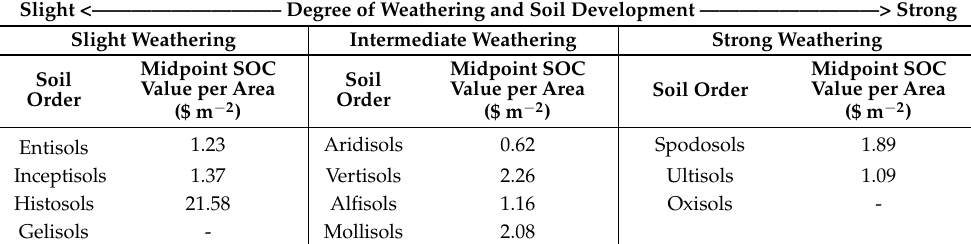
Table 14. Degree of soil development and area-normalized midpoint values of soil organic carbon (SOC) storage in the upper 2 m depth within the contiguous United States (U.S.), based on midpoint SOC numbers from Guo et al., 2006 [39] and a social cost of carbon (SC-CO 2 ) of $42 (USD) per metric ton of CO 2 [51].